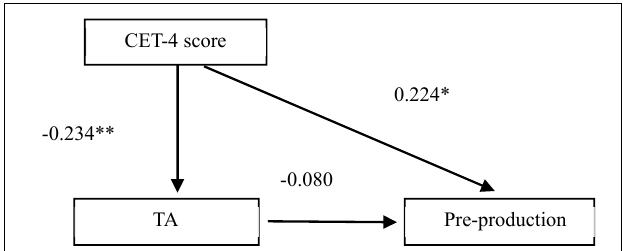
FIGURE 1 | The partial mediating effect of translation learning anxiety (TA). *The significant level is 0.05; **The significant level is 0.01.